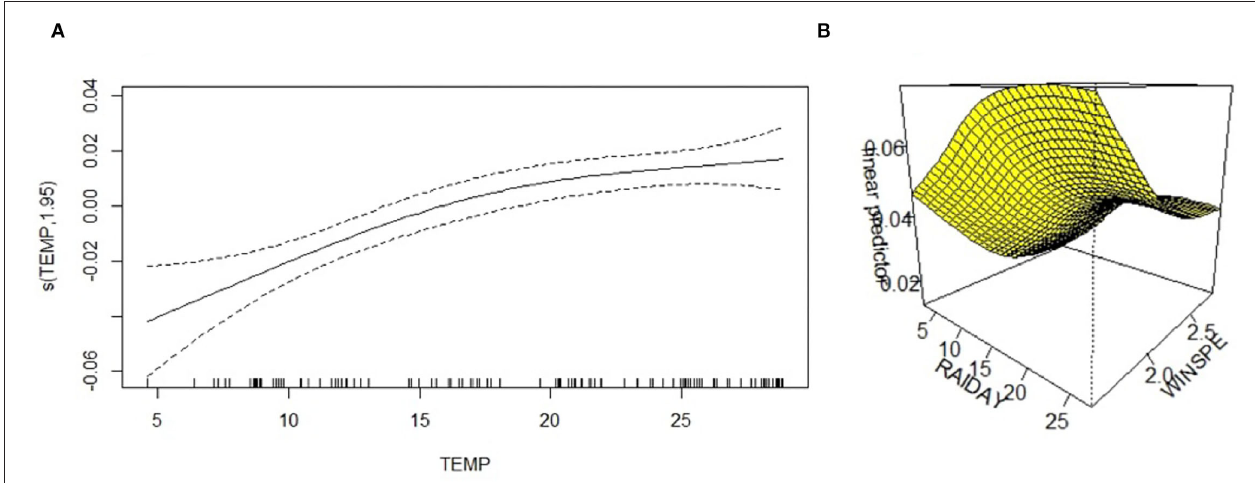
FIGURE 3 | A three-dimensional surface-fitting graph of the relationship between HPIV-3 detection rate and average temperature, precipitation days, and average wind speed; (A) The relationship between HPIV-3 detection rate and average temperature was nearly linearly. (B) Three-dimensional surface-fitting graph of the relationship between HPIV-3 detection rate, rainfall days and average windspeed using GAM; WINSPE, windspeed.